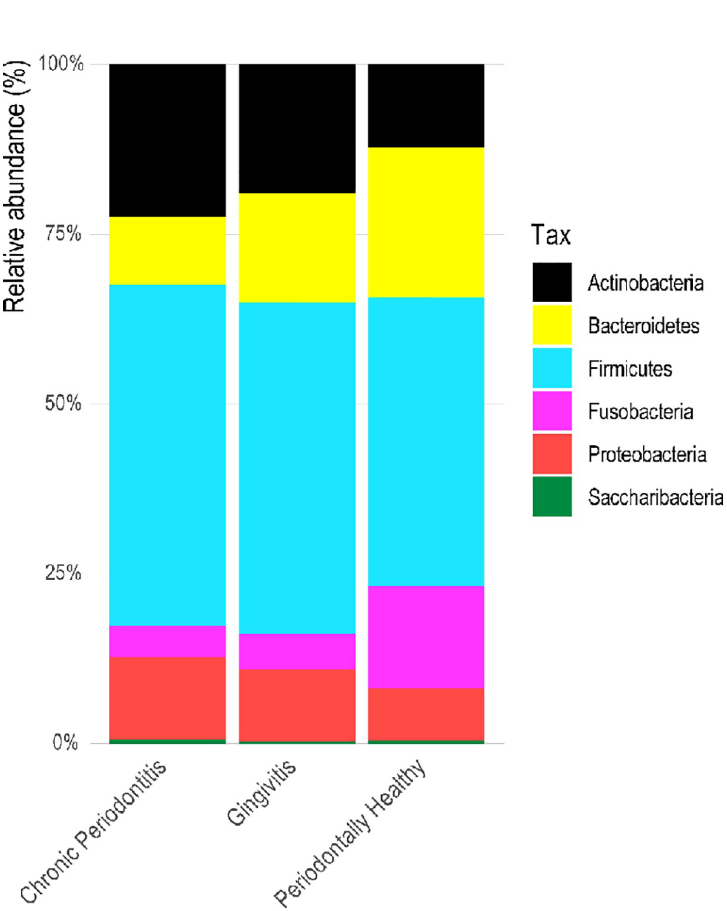
Fig 1. Relative proportion of bacterial phyla in healthy and diseased samples. Relative proportion refers to the percentage of each phyla (indicated by different colors) in a resistance group. Overall, 22 samples were analyzed being 4 (18.2%) retrieved from healthy patients, 12 (54.5%) from those with gingivitis, and 6 (27.3%) from those with chronic periodontitis.